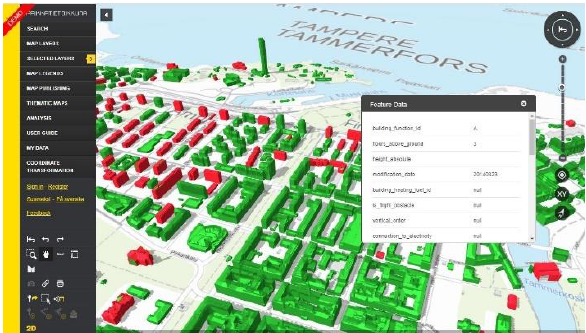
Figure 6 Tampere city 3D buildings with property information Helsinki city 3D model by the Helsinki Region Infoshare (HRI)